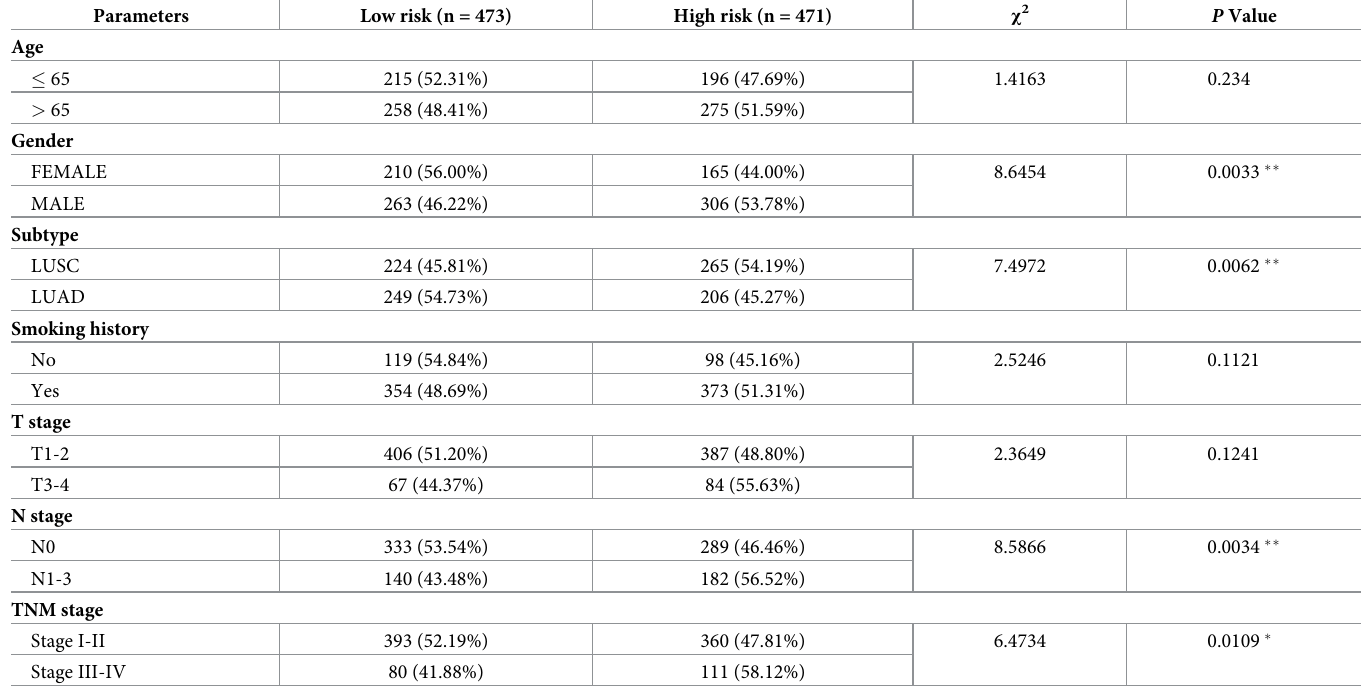
Table 3. The association between risk score of the 13-gene-based prognostic model and clinicopathological characteristics.